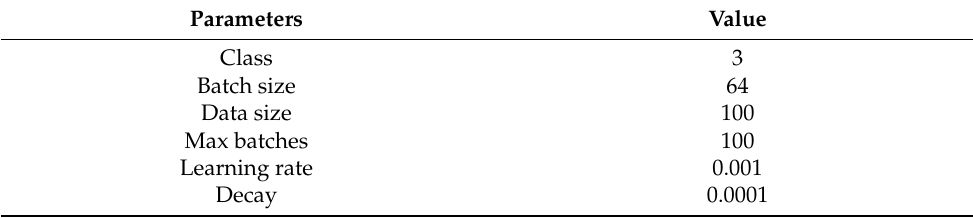
Table 11. Experimental setup for training the